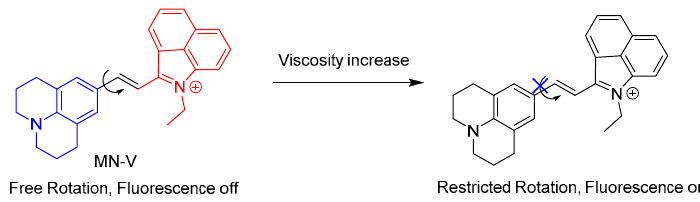
increase in HeLa cells during ferroptosis.